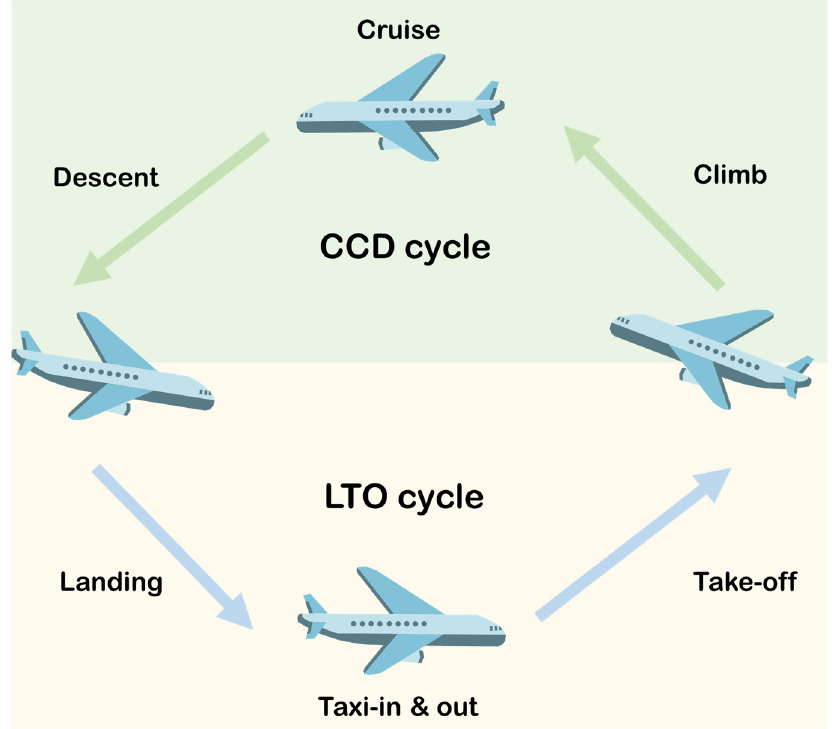
Figure 3. LTO and CCD flight phase cycle.